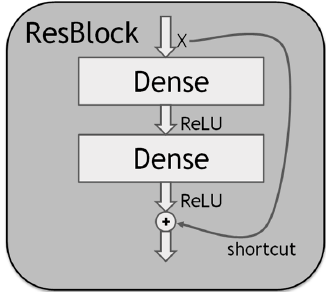
Figure 2. The residual block